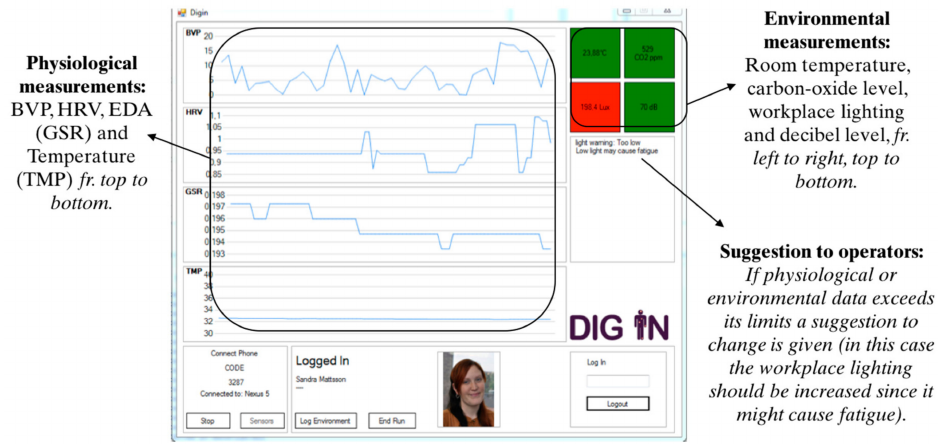
Figure 4. Prototype evaluated in